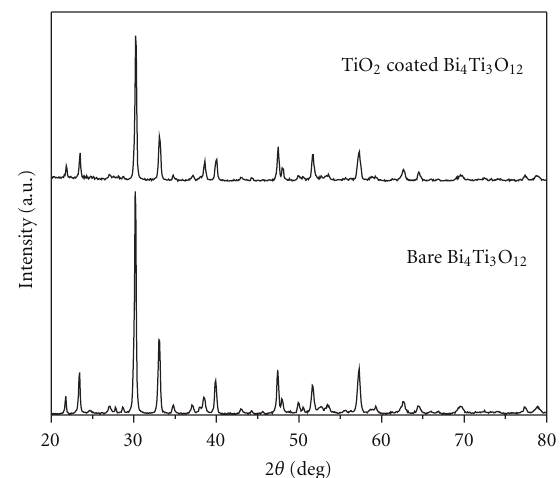
Figure 1: X-ray di ff raction pattern of Bi 4 Ti 3 O 12 - and TiO 2 -coated Bi 4 Ti 3 O 12 nanoparticles annealed at 690 ◦ C for